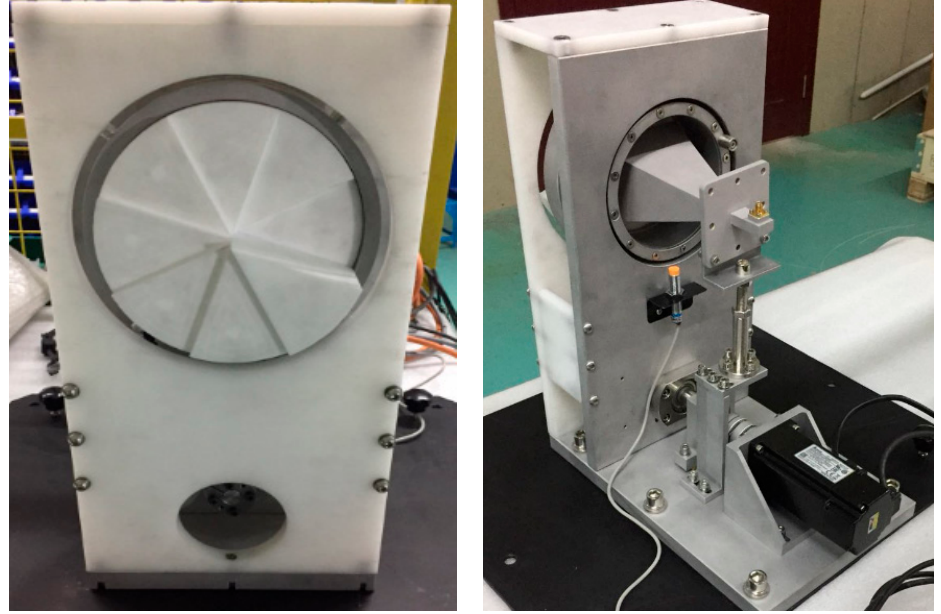
Figure 5. Prototypes of the transmitting antenna platform.